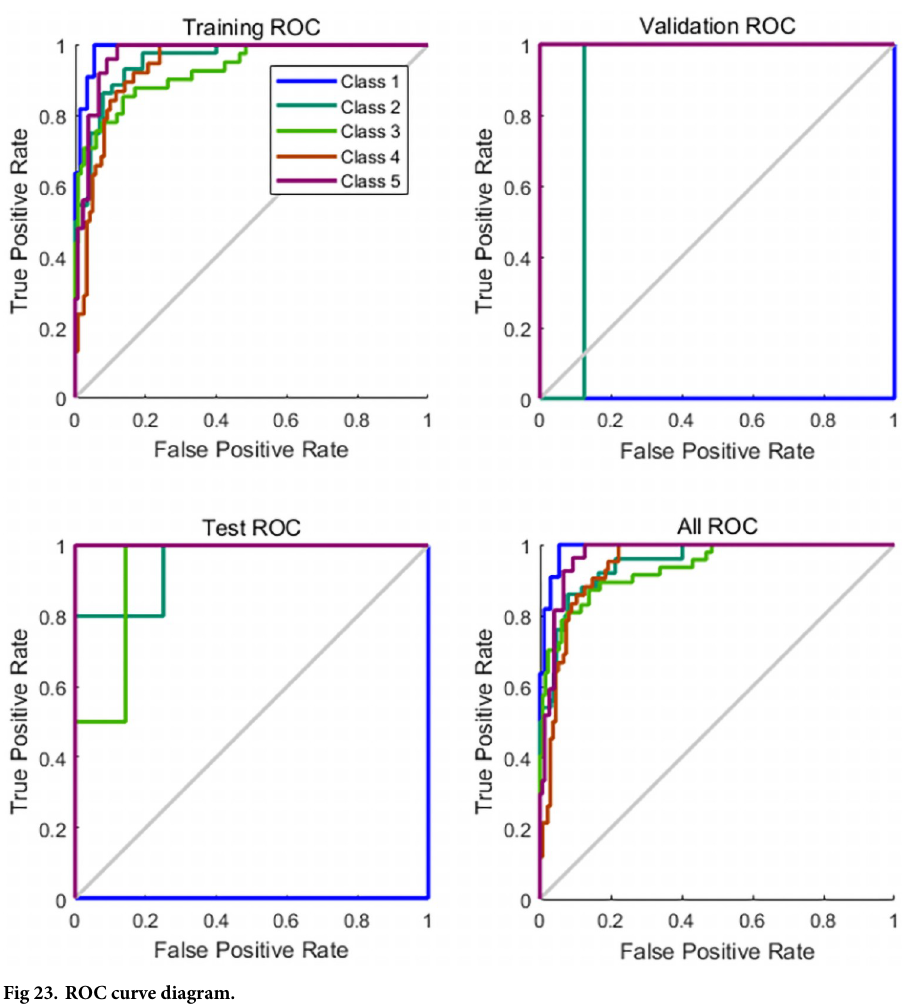
Fig 23. ROC curve